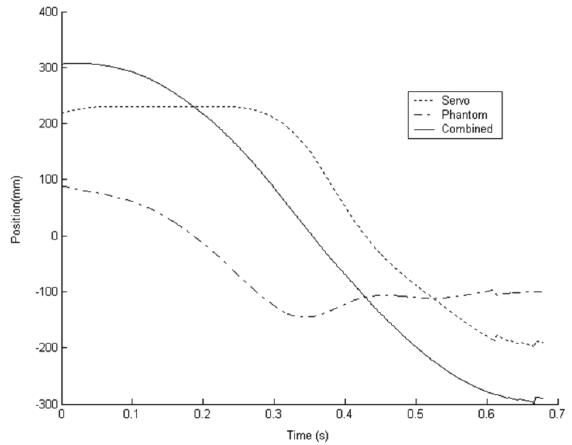
Figure 7. Averaged position profile for the reciprocal tapping task. The controller includes a dead-band component.